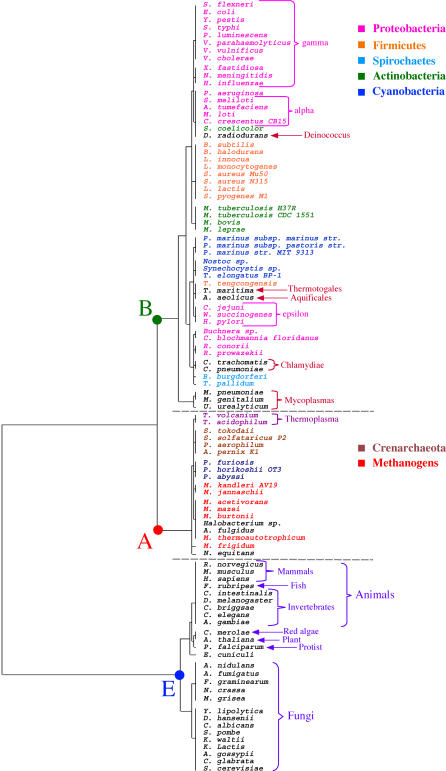
Genome Tree
Profiles tree based on Jaccard scores as obtained from the whole set of distinct conservation profiles.